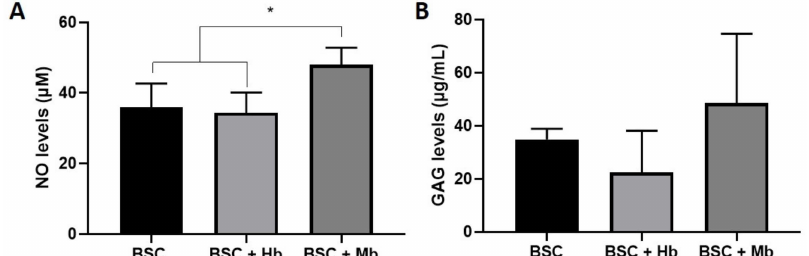
Figure 8. Biochemical analysis of secreted proteins by BAMs. Cell culture media from BAMs generated from BSC, BSC + Hb, or BSC + Mb (3 mg / mL for both heme proteins) was removed after 72 h of incubation and measured for ( A ) Nitric Oxide ( n = 5) and ( B ) Soluble GAGs ( n = 6) content. * p ≤ 0.05.